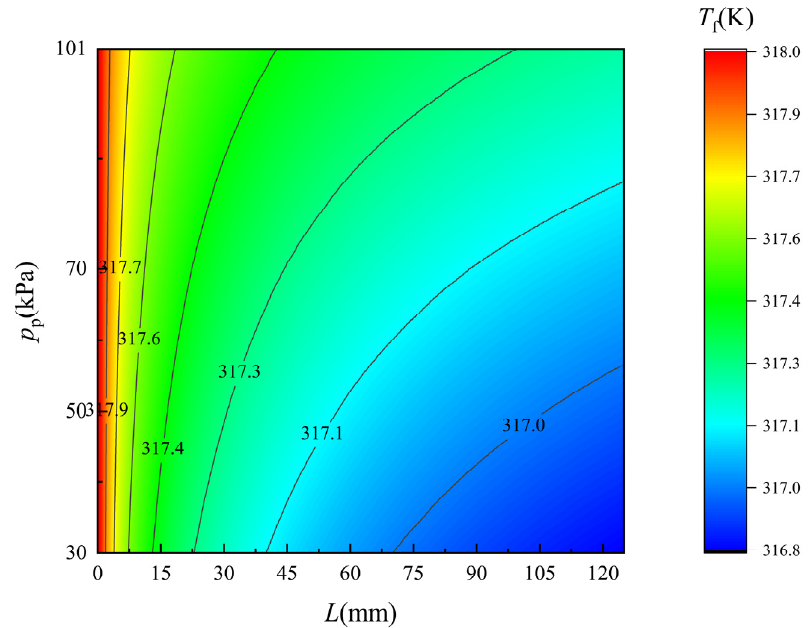
Figure 6. Temperature distribution of flow along the feed side membrane surface. T f = 318 K.